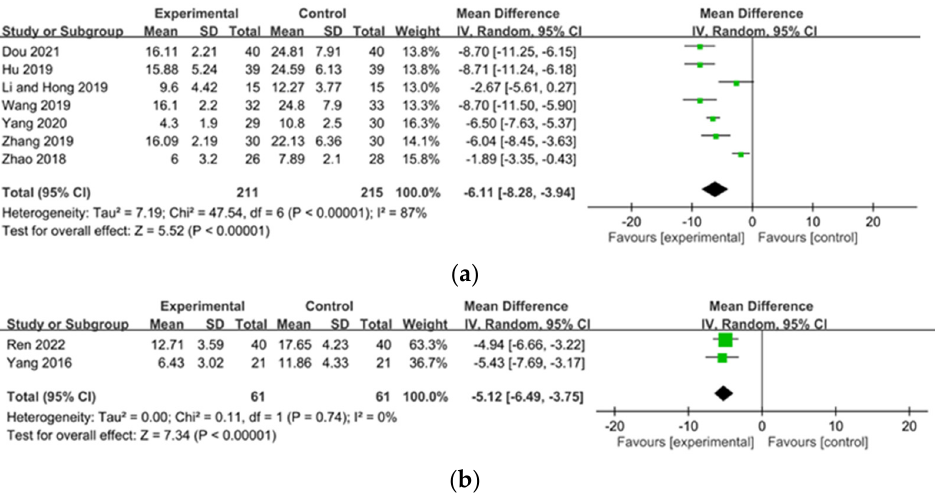
Figure 4. Forest plot of pruritus score: ( a ) Duo; ( b ) Dirk R. Kuypers itching scale in patients with uremic pruritus treated with Chinese herbal medicine.